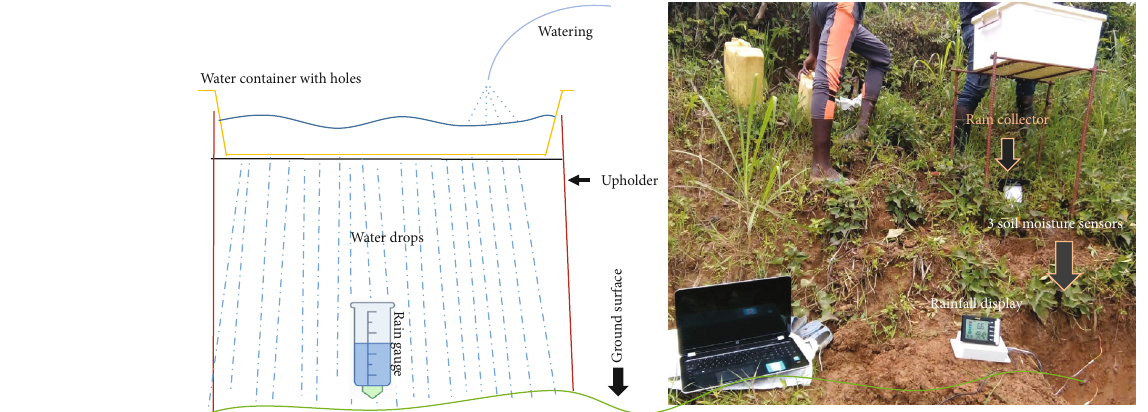
Figure 5: Rainfall